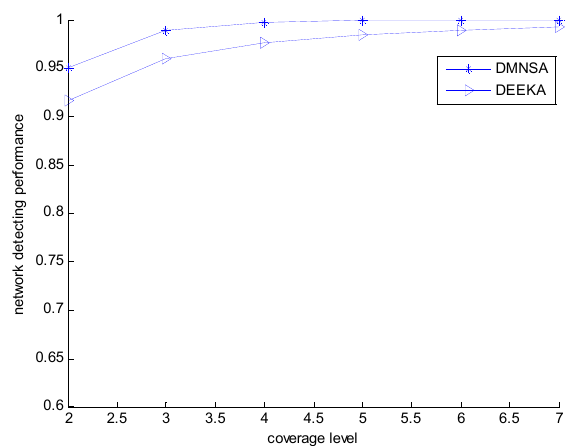
Figure 14. Network detecting performance with varying K.